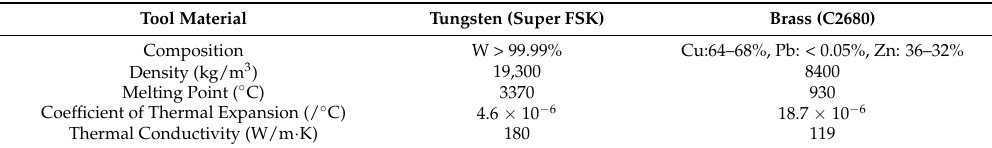
Table 2. Properties of tool materials.